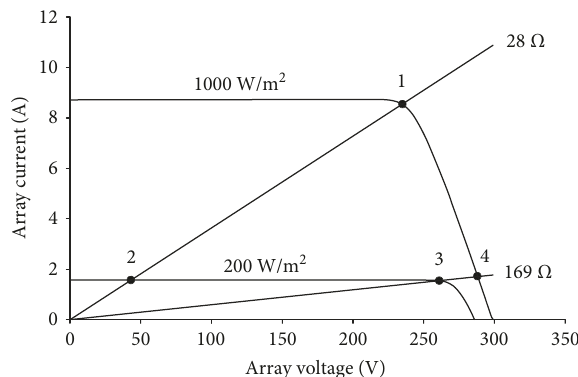
Figure 1: Electric (I-V) characteristics of photovoltaic array 2kW (8 × 250W in series). p